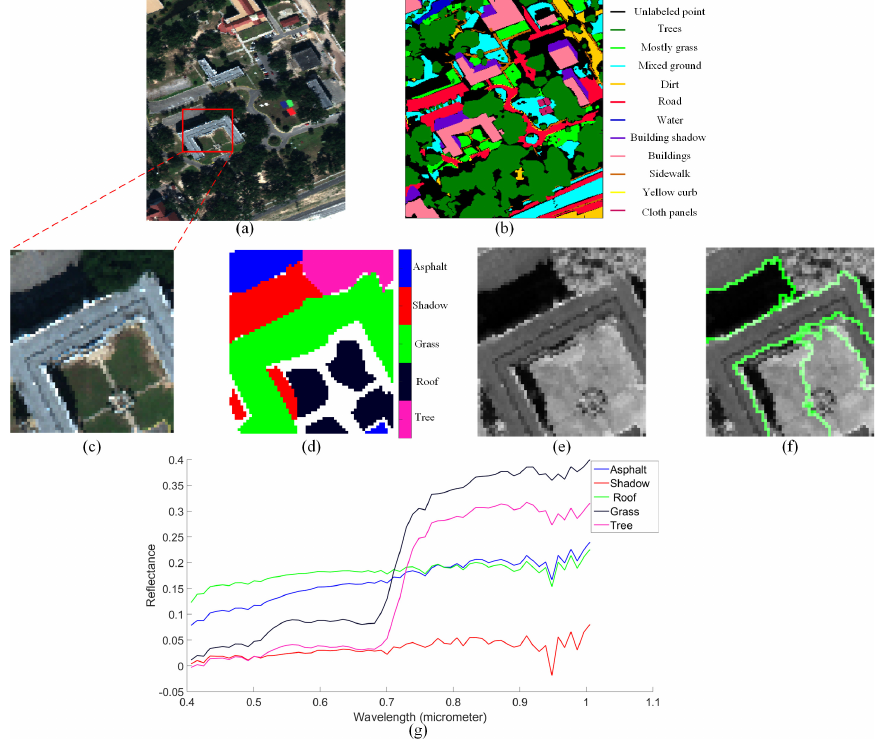
Figure 6. ( a ) The original RGB image of the Mississippi Gulfport dataset; ( b ) the original ground truth map; ( c ) the selected ROI 58 by 65 pixels; ( d ) ground truth materials of asphalt, grass, shadow, tree and grey roof in the ROI; ( e ) the first principle component of the Gulfport dataset; ( f ) the superpixel map used for the Gulfport dataset; and ( g ) the mean spectra of the five